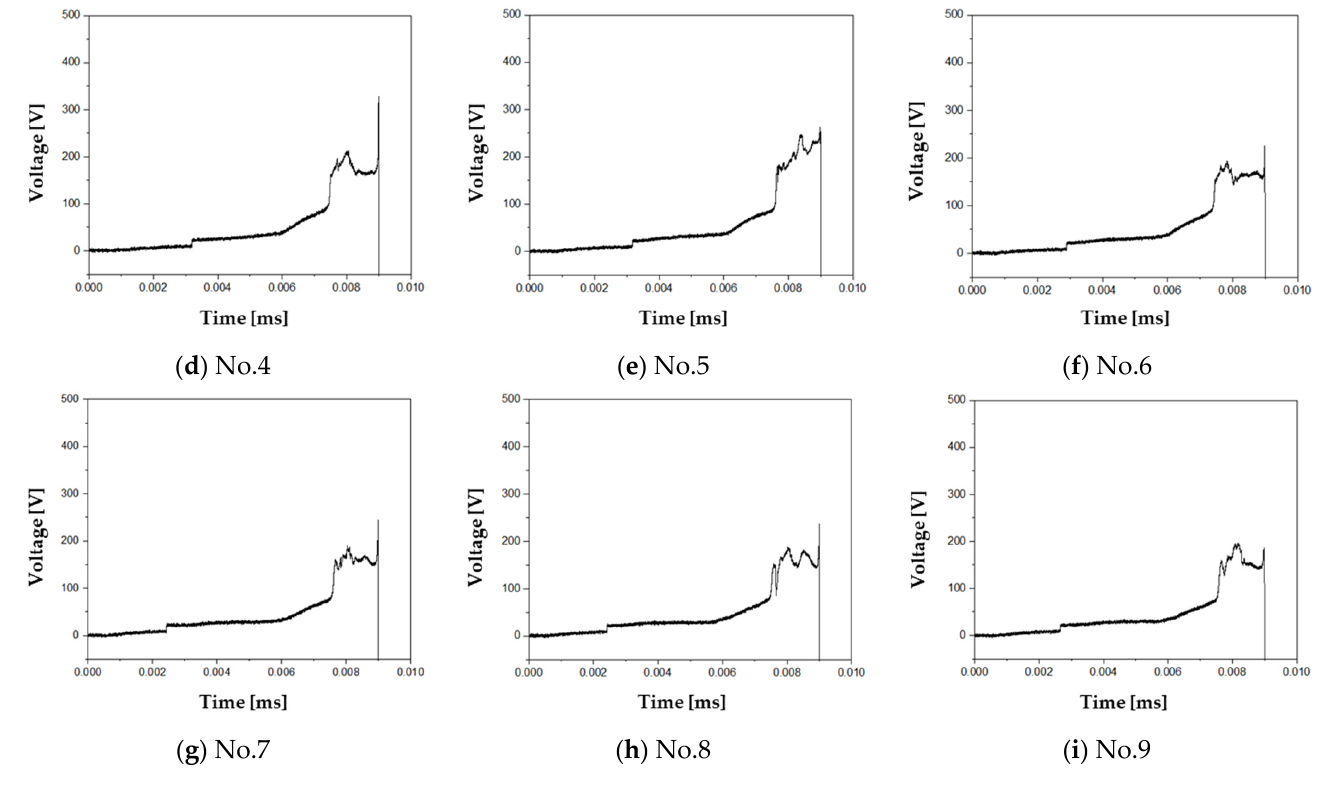
Figure 7. Short-circuit characteristics at 35 °C.